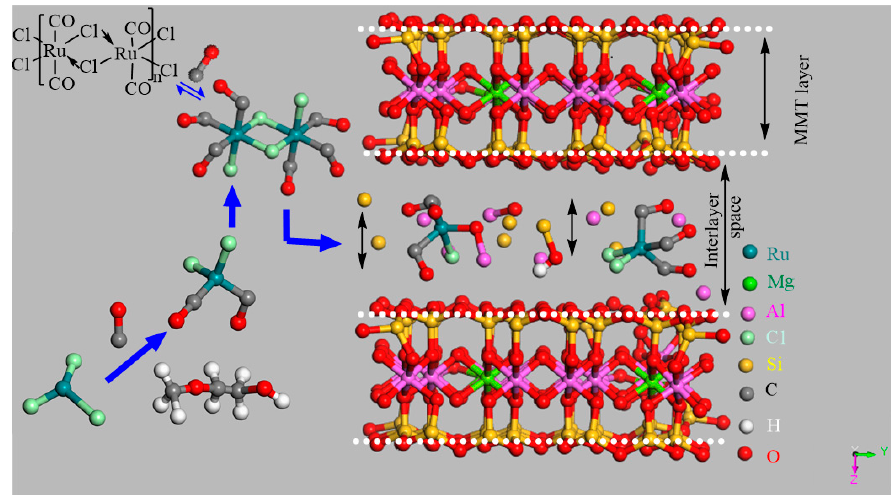
Figure 1. The intercalation of CO-releasing molecule-2 (CORM-2) [Ru(CO) 3 Cl 2 ] 2 inside the Montmorillonite (MMT) layers presented through Material Studio